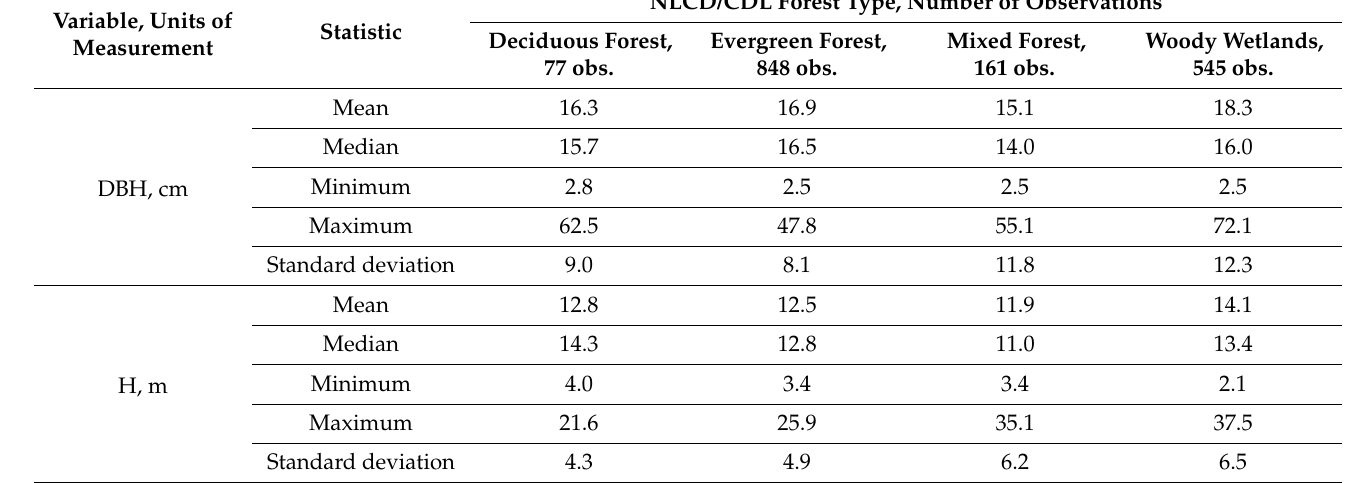
Table 4. FIA 2009–2013 Duplin County sample: Summary statistics.